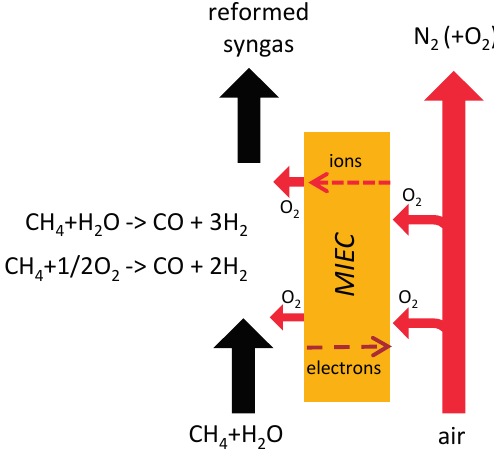
Figure 1. Schematic of an ATR-MR based on oxygen transport